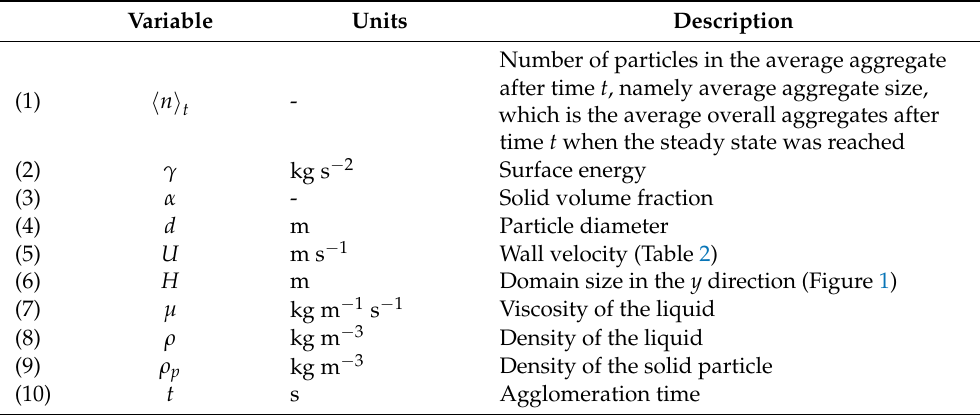
Table 1. Variables for dimensional analysis.